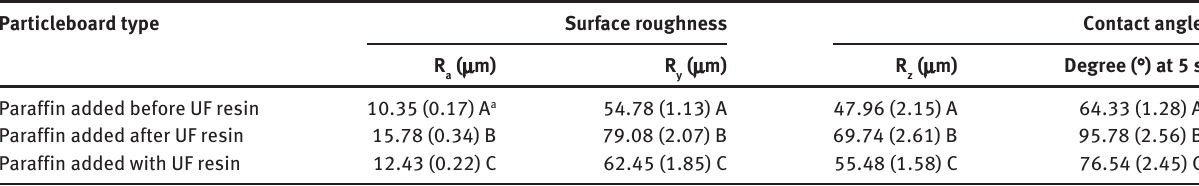
Table 1 Surface properties of the